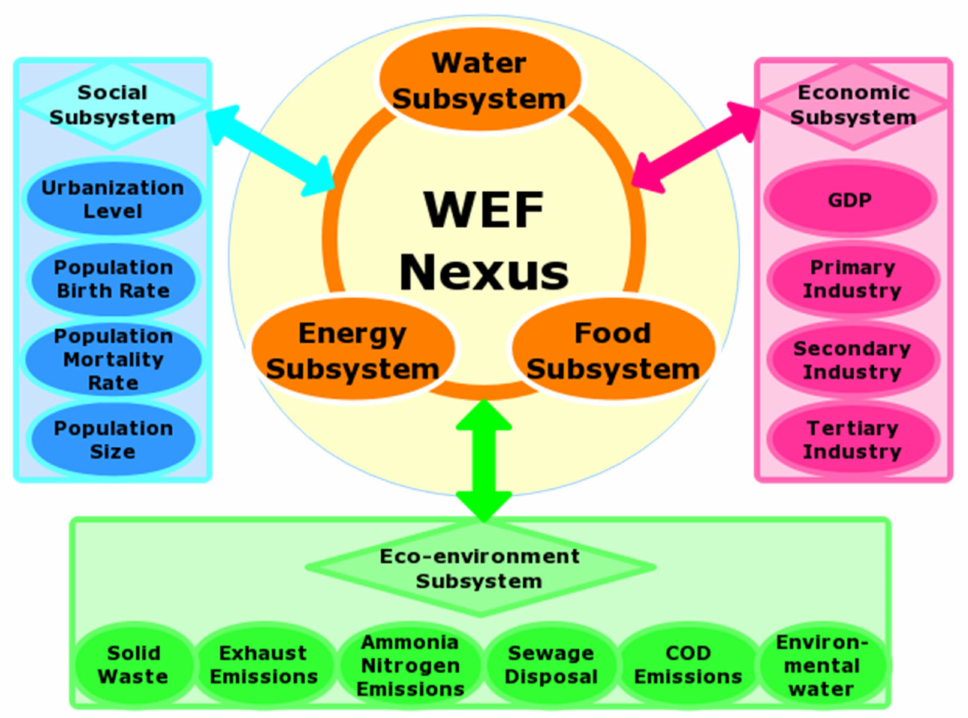
Figure 2. Framework of the water–energy–food (WEF) nexus system dynamics (SD)